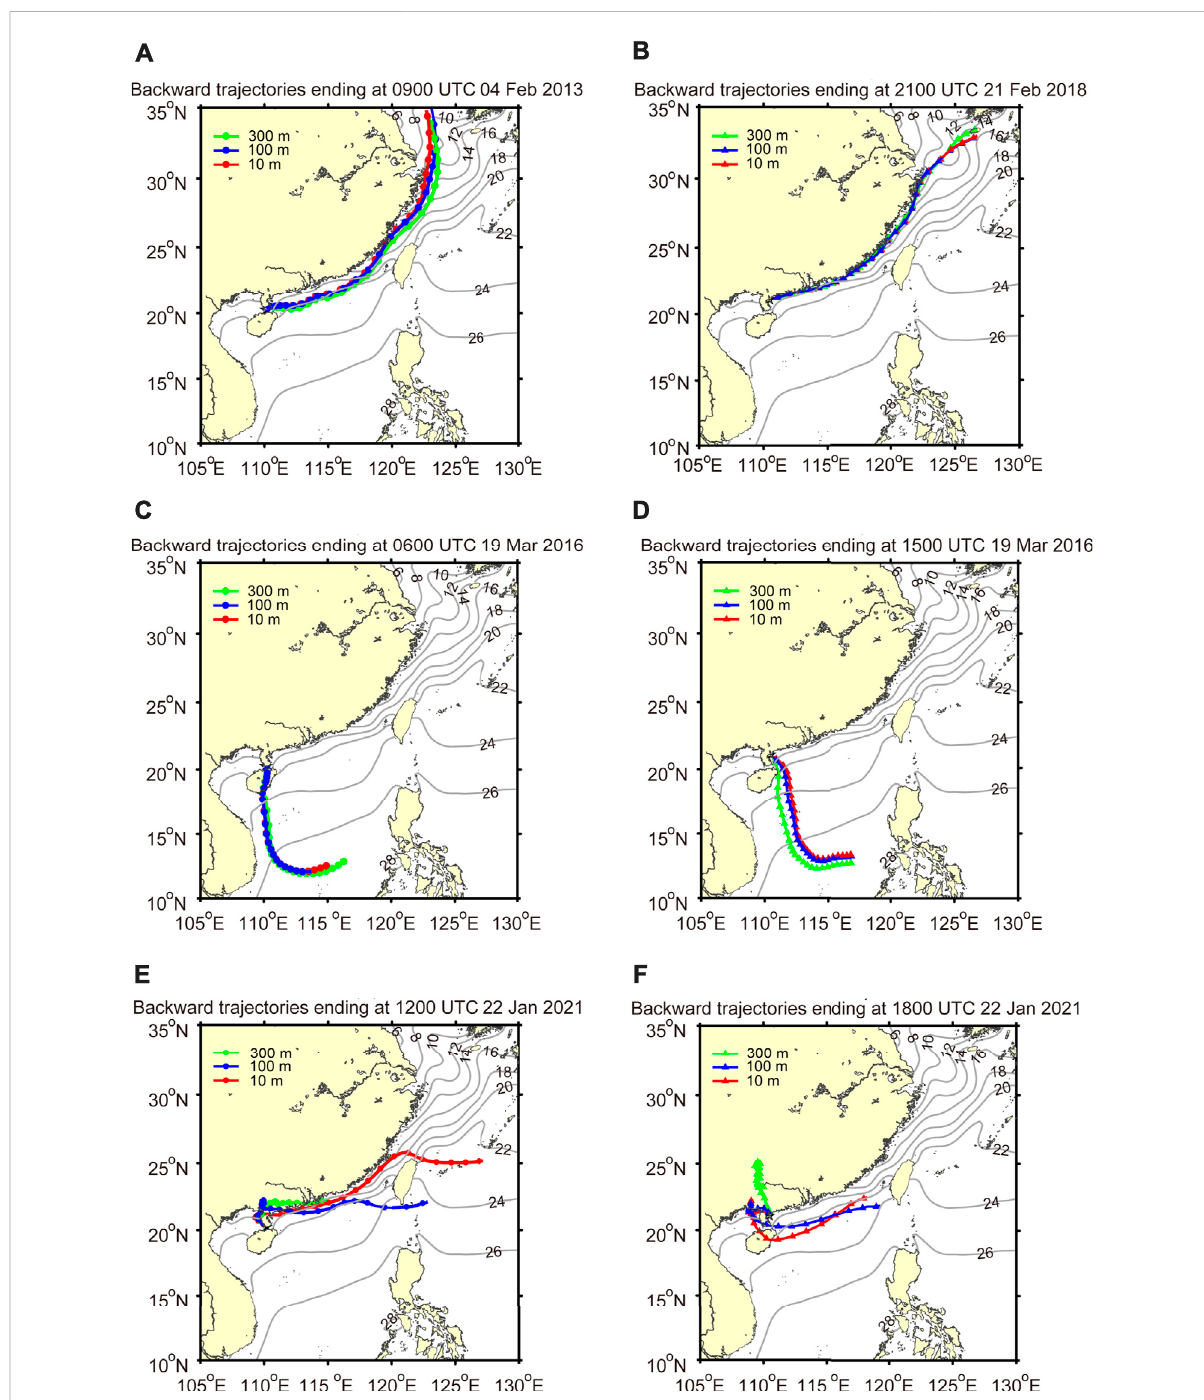
FIGURE 5 Trajectories for the fog types. Left side: Xuwen harbor. Right side: Zhanjiang harbor. Top row (A,B) : Typical trajectory for cold advection fog. Middle row (C,D) : warm advection fog. Bottom row (E,F) : abnormal